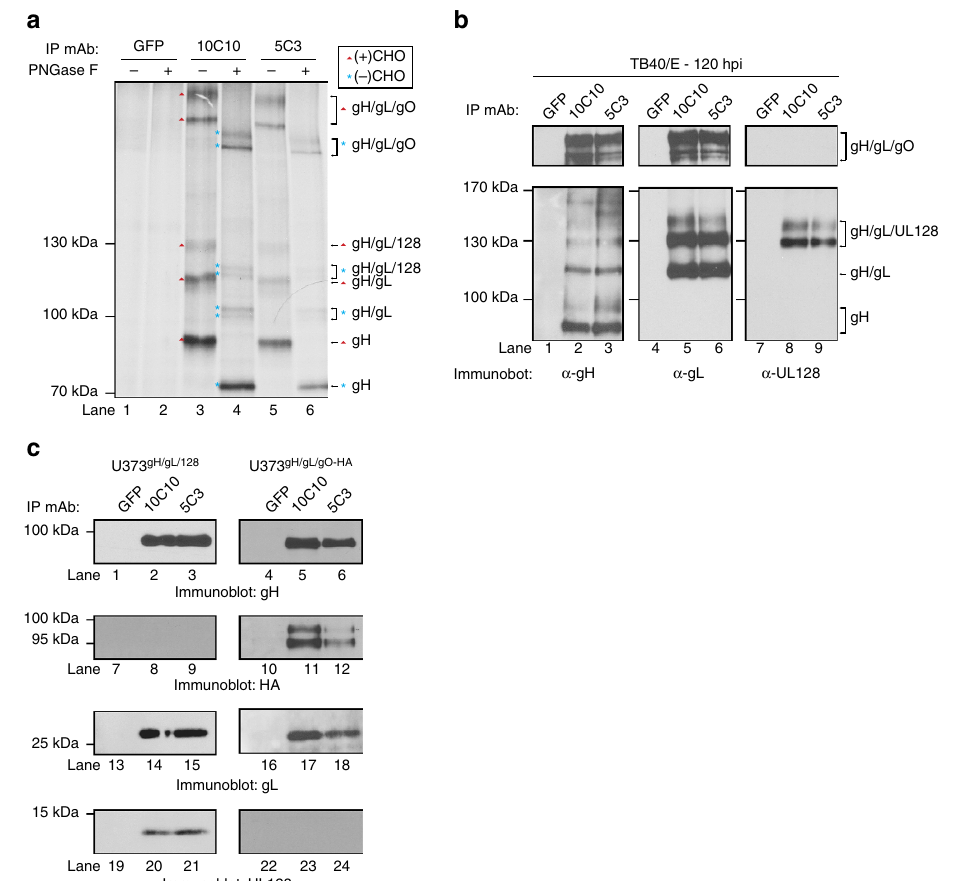
Figure 5 | a -gH mAbs bind to multiple glycoprotein complexes ( a ) Lysates from metabolically labelled TB40/E-infected MRC5 cells were exposed to an isotype control mAb recognizing GFP, or mAb 10C10 and 5C3. Recovered immune complexes were split and treated with PNGase F, then resolved by non- reducing SDS–PAGE. Arrows denote the identity of glycosylated protein complexes and asterisks denote the identity of de-glycgosylated protein complexes. ( b ) Lysates from TB40/E-infected MRC5 cells were exposed to a GFP mAb, 10C10 or 5C3. Immune complexes were resolved by non-reducing SDS–PAGE followed by immunoblot for gH (lanes 1–3), gL (lanes 4–6) and UL128 (lanes 7–9). Lines denote the glycoprotein complexes. ( c ) Lysates from U373 cells stably expressing gH/gL/UL128 (U373 gH/gL/UL128 ) and gH/gL/gO-HA (U373 gH/gL/gO-HA ) were exposed to GFP, 10C10 or 5C3 mAbs and the recovered immune complexes were resolved by SDS–PAGE and subjected to immunoblot for gH (lanes 1–6), HA (lanes 7–12), gL (lanes 13–18) and UL128 (lanes